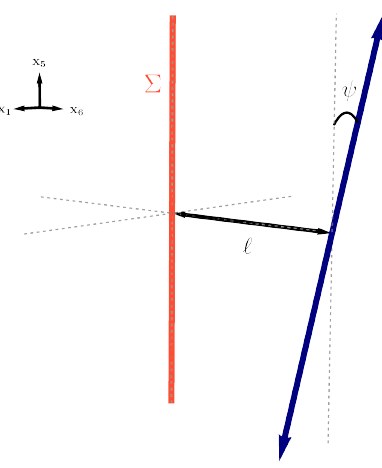
Figure 1 . Configuration for the null geodesic v µ described in eq. (4.33). The null geodesic (blue) passes by the defect (orange, labelled Σ ) at an angle ψ in the x 1 − x 5 plane and at a distance ‘ away in the x 6